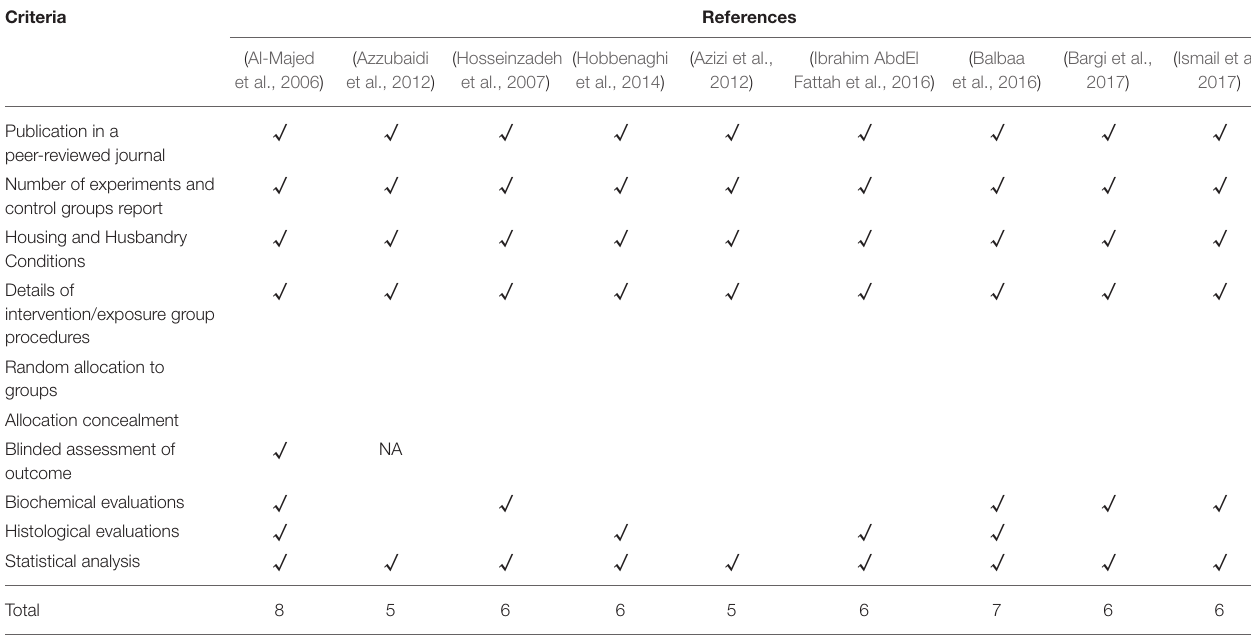
TABLE 3 | The quality of evidence obtained by using a modified CAMARADES (Macleod et al., 2004).